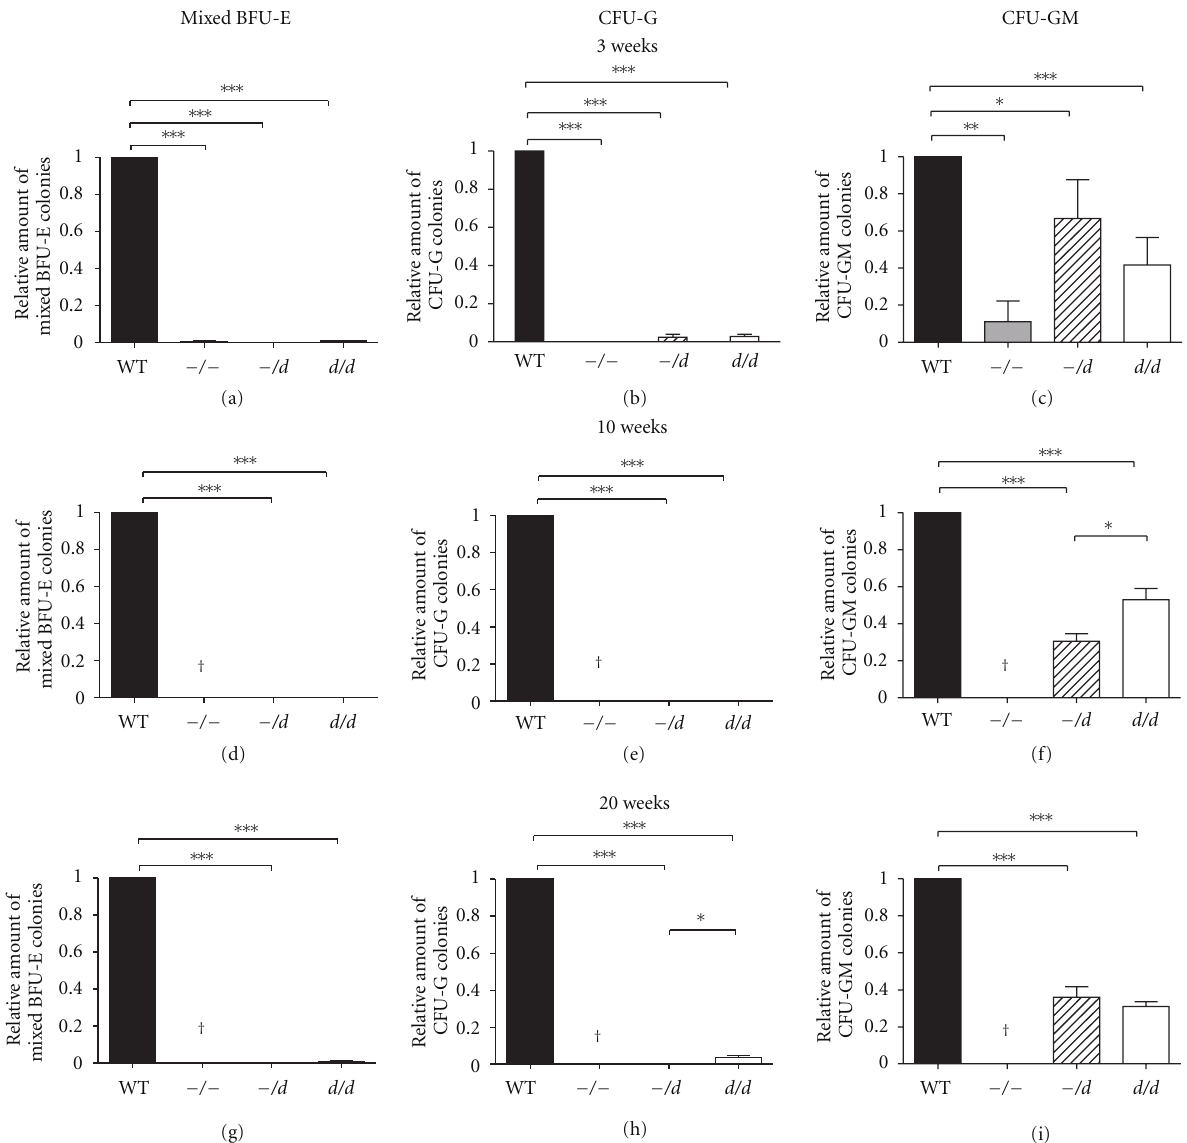
Figure 4: Colony-forming potential of bone marrow progenitors is a ff ected in hypomorphic models or Ercc1. BFU-E, CFU-G, and CFU- GM colonies per 5 × 104 bone marrow cells derived from ((a)–(c)) 3-week-old Ercc1 − / − ( n = 6), Ercc1 − /d ( n = 7), Ercc1 d/d ( n = 4), and wt mice ( n = 7) ((d)–(f)) 10-week-old Ercc1 − /d ( n = 3), Ercc1 d/d ( n = 3), and wt mice ( n = 3), ((g)–(i)) 20-week-old Ercc1 − /d ( n = 3), Ercc1 d/d ( n = 6), and wt mice ( n = 8). Error bars indicate standard deviation. ∗ indicates P ≤ 0 . 05, ∗∗ indicates P ≤ 0 . 01, and ∗∗∗ indicates P ≤ 0 .